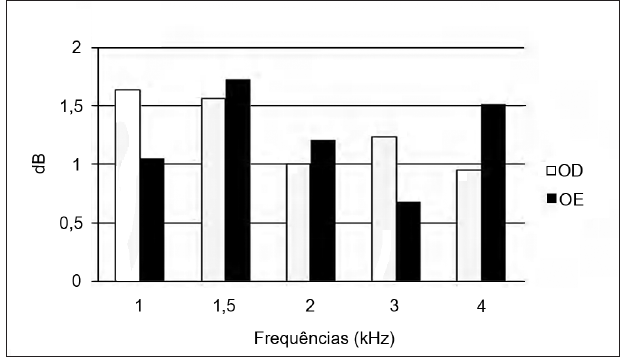
Figura 2. Média da amplitude de supressão das EOATs por faixa de frequência nas orelhas direita e esquerda. OD - orelha direita. OE - orelha esquerda.